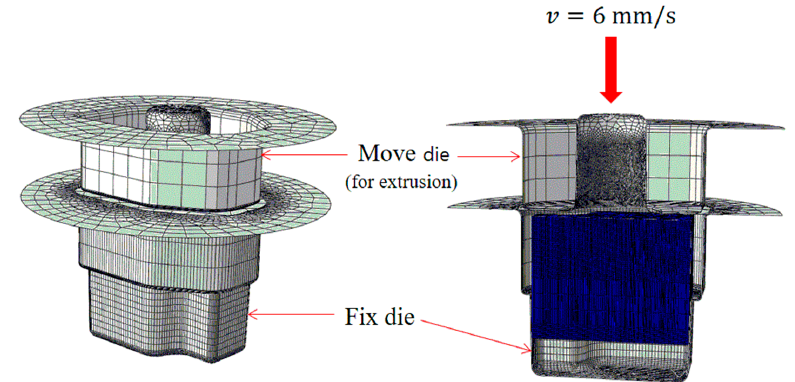
Figure 7. Boundary conditions of hot extrusion for blocker forming.